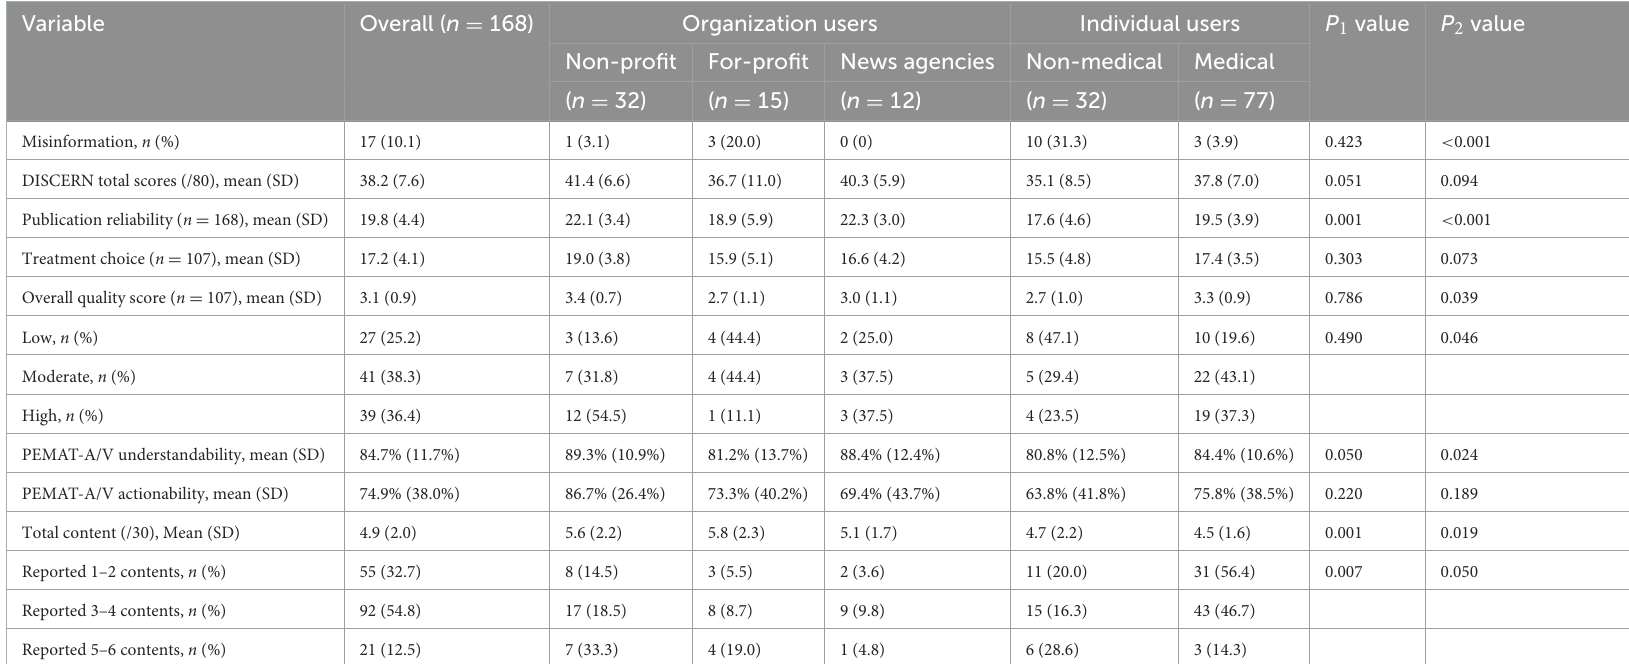
TABLE 3 Videos content and quality scores by